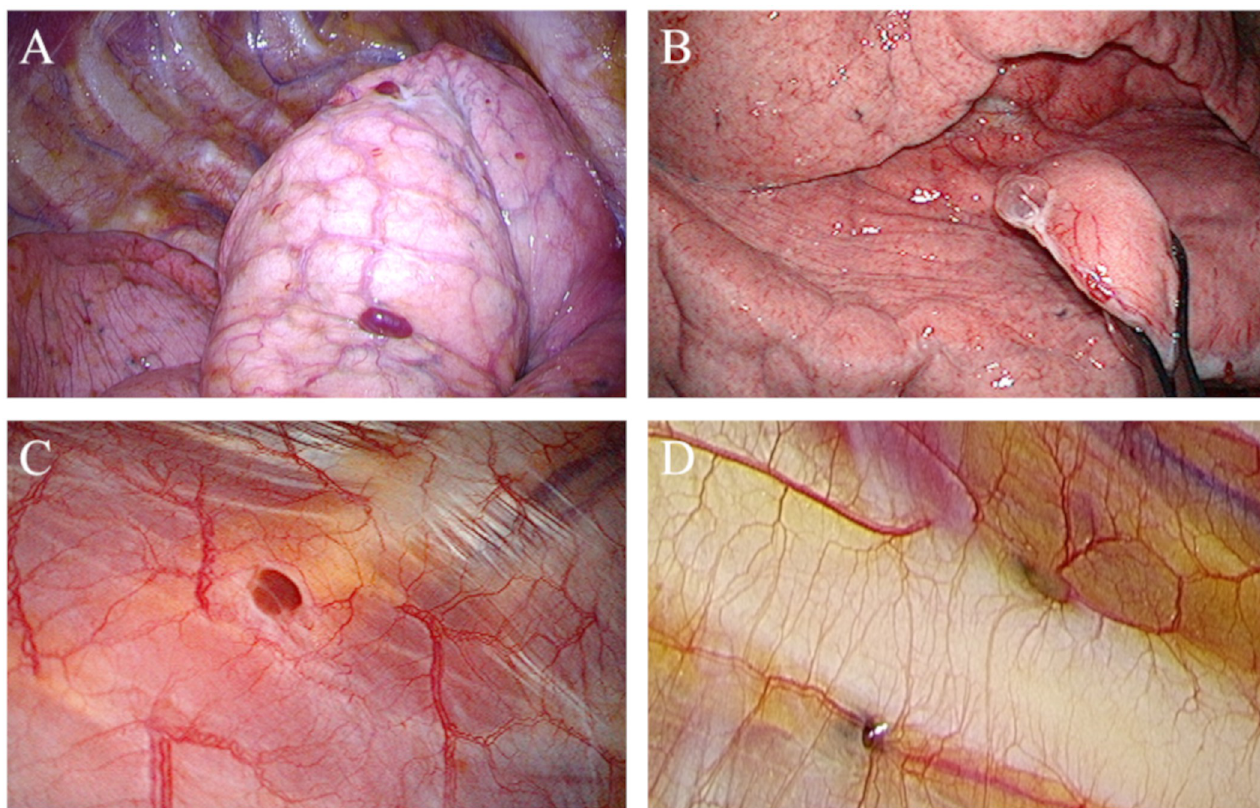
Fig 1. Visual aspect of visceral and parietal pleural endometriosis. Visceral pleural endometriosis showed (A) brown nodule, and (B) cystic lesion. Brown nodule was like a hematoma, to say it in another way blueberry spot. Parietal pleural endometriosis showed (C) brown nodule, and (D) dent of the pleura called depressed